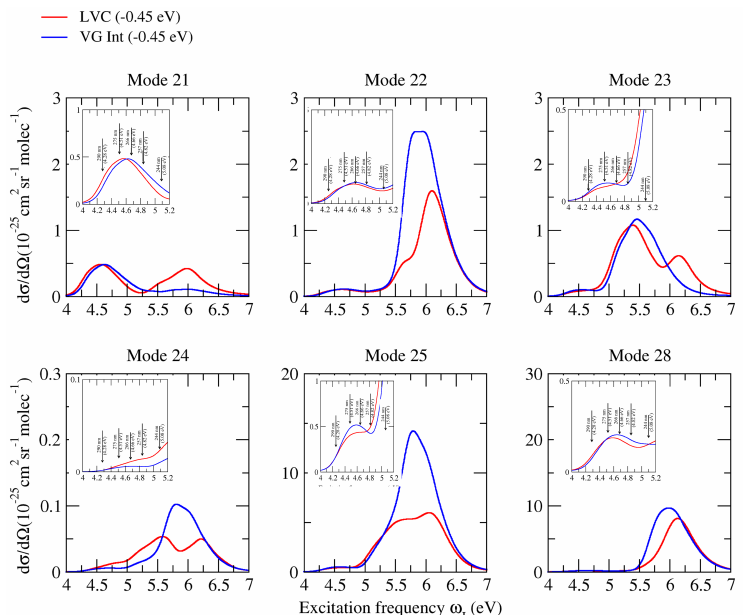
Figure 7. Raman excitation profiles of the six modes of cytosine, computed at non-adiabatic LVC level, and VG Int convoluted with a Lorentzian with damping γ = 0.04 eV and a Gaussian of HWHM = 0.12 eV, calculated by CAM-B3LYP and the 6-311G+(d,p) basis sets in